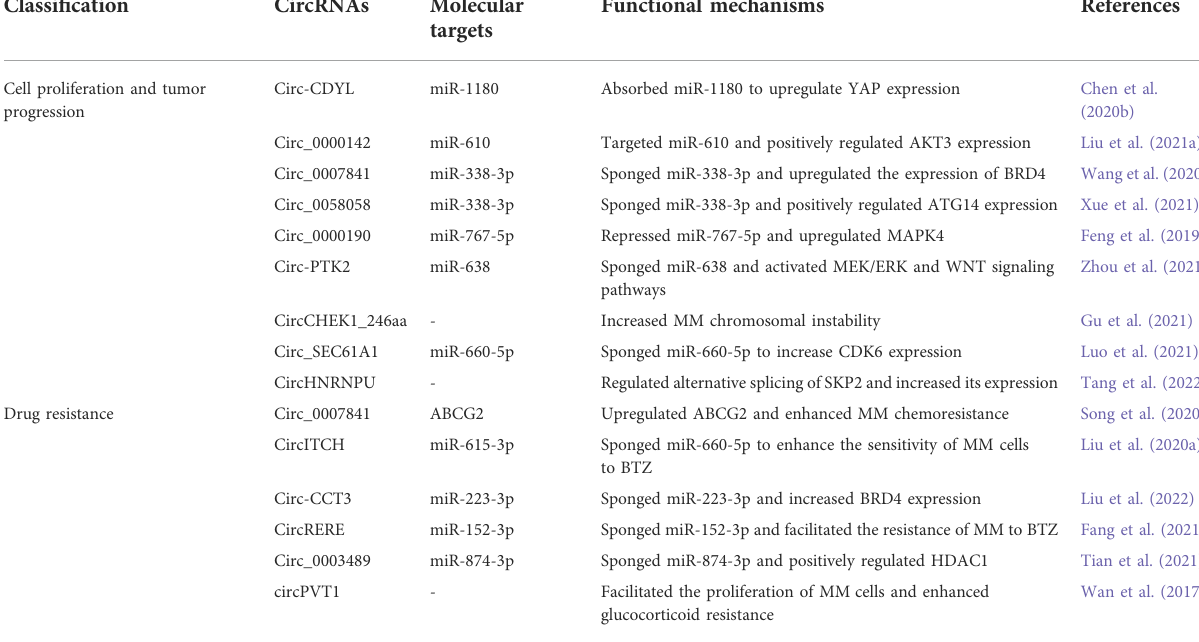
TABLE 2 Functional mechanisms of circRNAs in